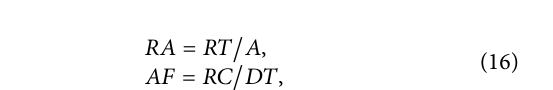
Frontiers in Earth Science |